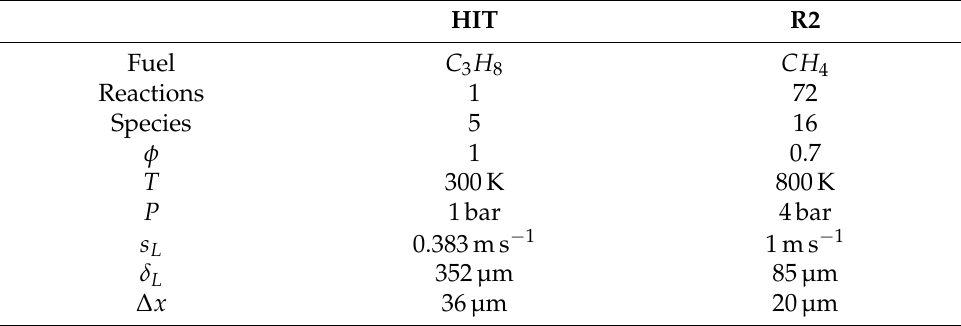
Table 2. Main differences in the simulation parameters of the HIT and R2